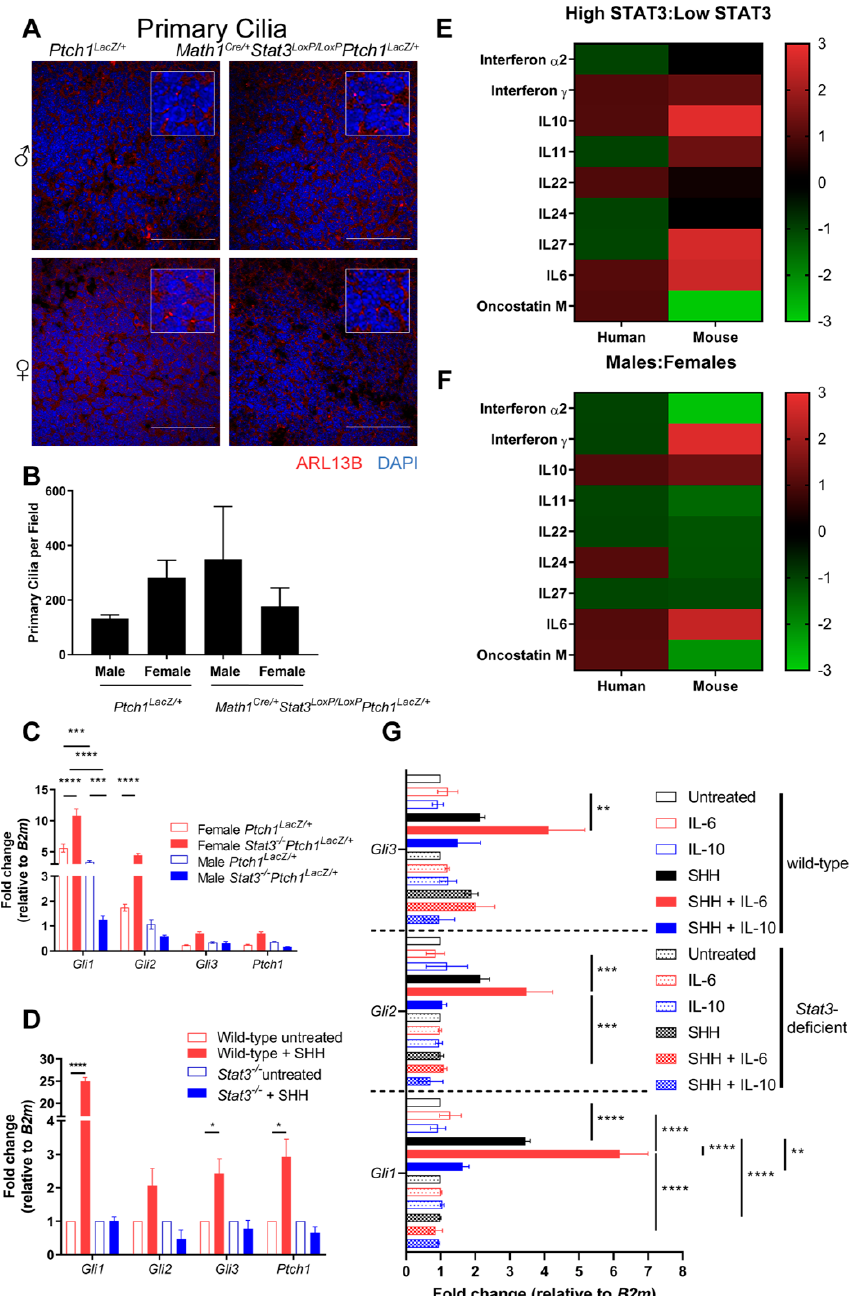
Figure 4. Stat3 is required for SHH-mediated gene transcription. ( A ) Analysis of primary cilia formation by immunofluorescent staining cerebellum ARL13B and DAPI did not reveal significant differences in male or female Ptch1 LacZ /+ control or Math1 Cre /+ Stat3 LoxP / LoxP Ptch1 LacZ /+ mice. ( B ) Cilia were quantified in three biological replicates (at least 100 cells per replicate) except for Math1 Cre /+ Stat3 LoxP / LoxP Ptch1 LacZ /+ males where only duplicates were available). ( C) qRT-PCR analysis for Gli1 , Gli2 , Gli3 and Ptch1 transcripts from tumor tissue taken from male and female mice of the indicated genotypes. ( D ) Wild-type and Stat3 − / − MEFs were stimulated with SHH for 24 hours and expression of Gli1 , Gli2 , Gli3 and Ptch1 transcripts was measured by qRT-PCR. ( E ) High STAT3 vs. Low STAT3 heatmap. ( F ) Male vs. female heatmap. ( G ) qRT-PCR analysis for Gli1 , Gli2 and Gli3 transcripts in WT and Stat3 − / − MEFs stimulated with IL-6, IL-10 and SHH Data are representative fields of immunohistochemistry or mean ± SEM of three biological replicates (* p < 0.05, ** p < 0.01, *** p < 0.001, **** p < 0.0001).